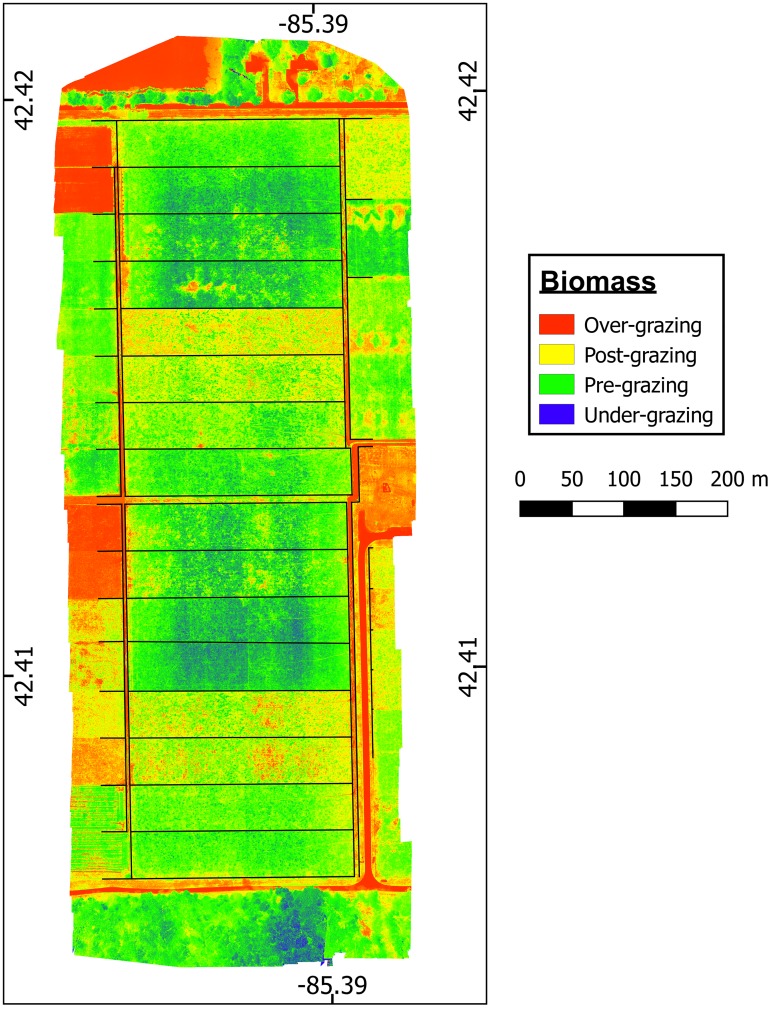
Example (Flight 4) of output map of estimated pasture biomass for a platform of 15.6 ha rotationally grazed with lactating cows in Exp. 2.The map shows high-resolution (6 cm) spatial variability of pasture cover with colors denoting <500 kg DM ha-1 (red), 500–1700 kg DM ha-1 (yellow), 1700–2800 kg DM ha-1 (green) and > 2800 kg DM ha-1 (blue).